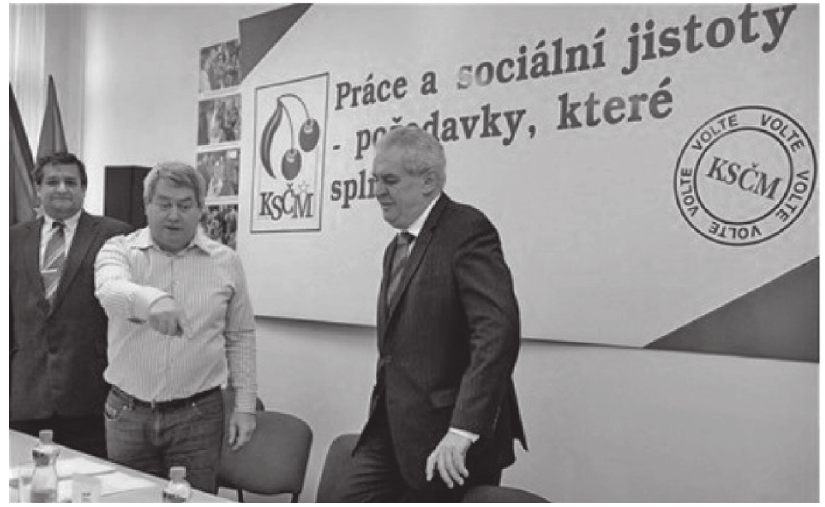
Fig. 4. Miloš Zeman, Lidovky.cz , 12. 1.